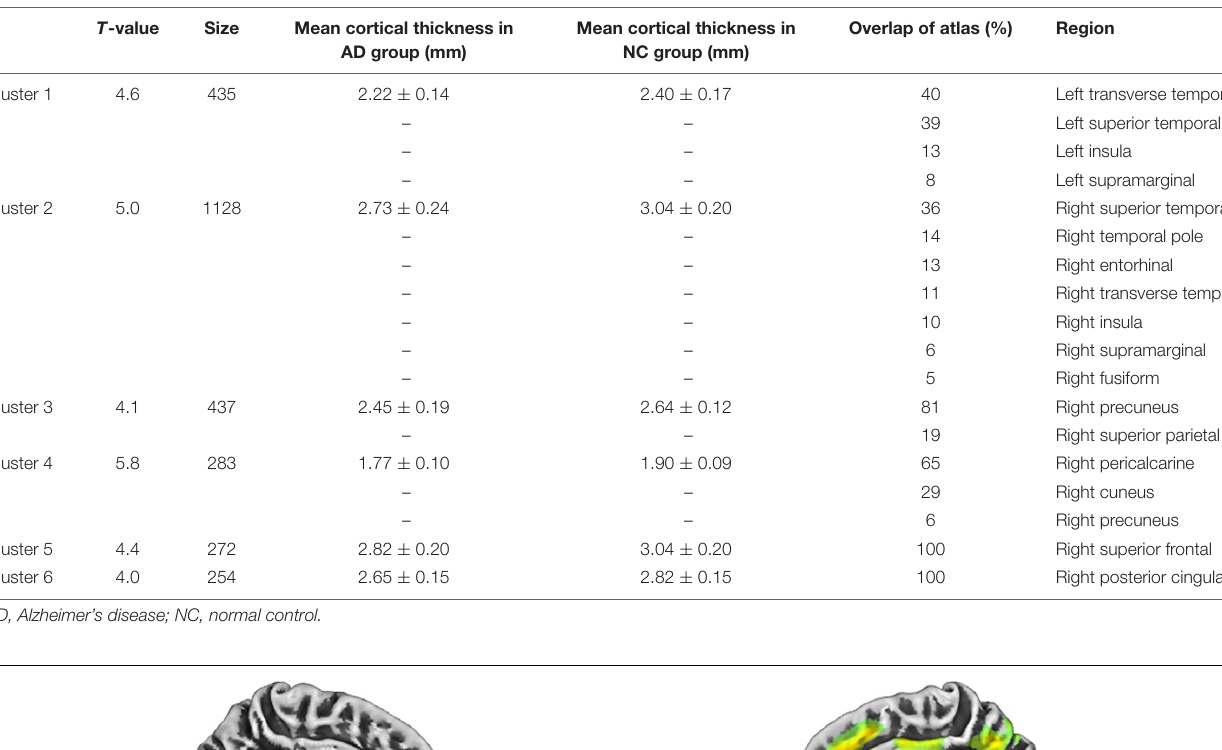
TABLE 2 | Brain regions with reduced cortical thickness in the AD-NC groups.